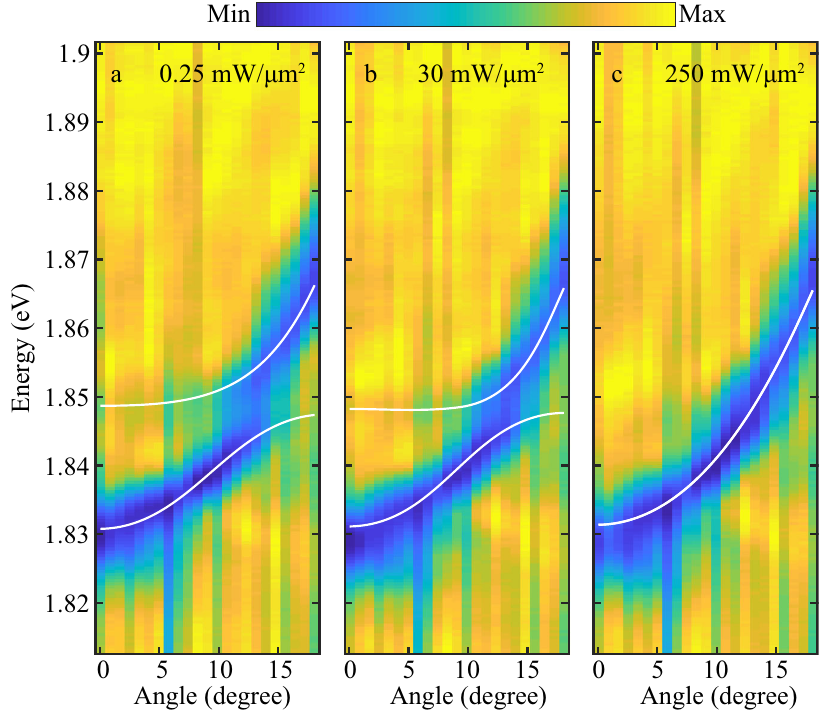
Fig. 3 White light intensity dependent cavity re fl ection. a – c Angle resolved re fl ection for different incident intensities of 0 : 25 mW = μ m 2 ( a ), 30 mW = μ m 2 ( b ), and 250 mW = μ m 2 ( c ). Higher intensities imply a higher density of polaritons, which eventually leads to an excitation blockade induced by the strong interaction between excitons. This polariton blockade reduces the effective coupling to the cavity, observed as a decreasing splitting of the two polariton branches in our experiments. The analysis for nonlinear interacion is carried out below 30 mW/ µ m 2 where the system is well under the strong coupling